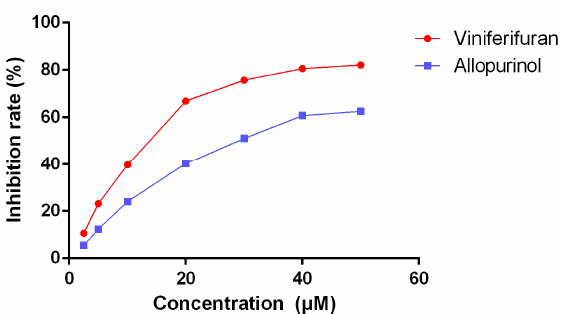
Figure 2. Inhibitory effect of viniferifuran and allopurinol on XO.